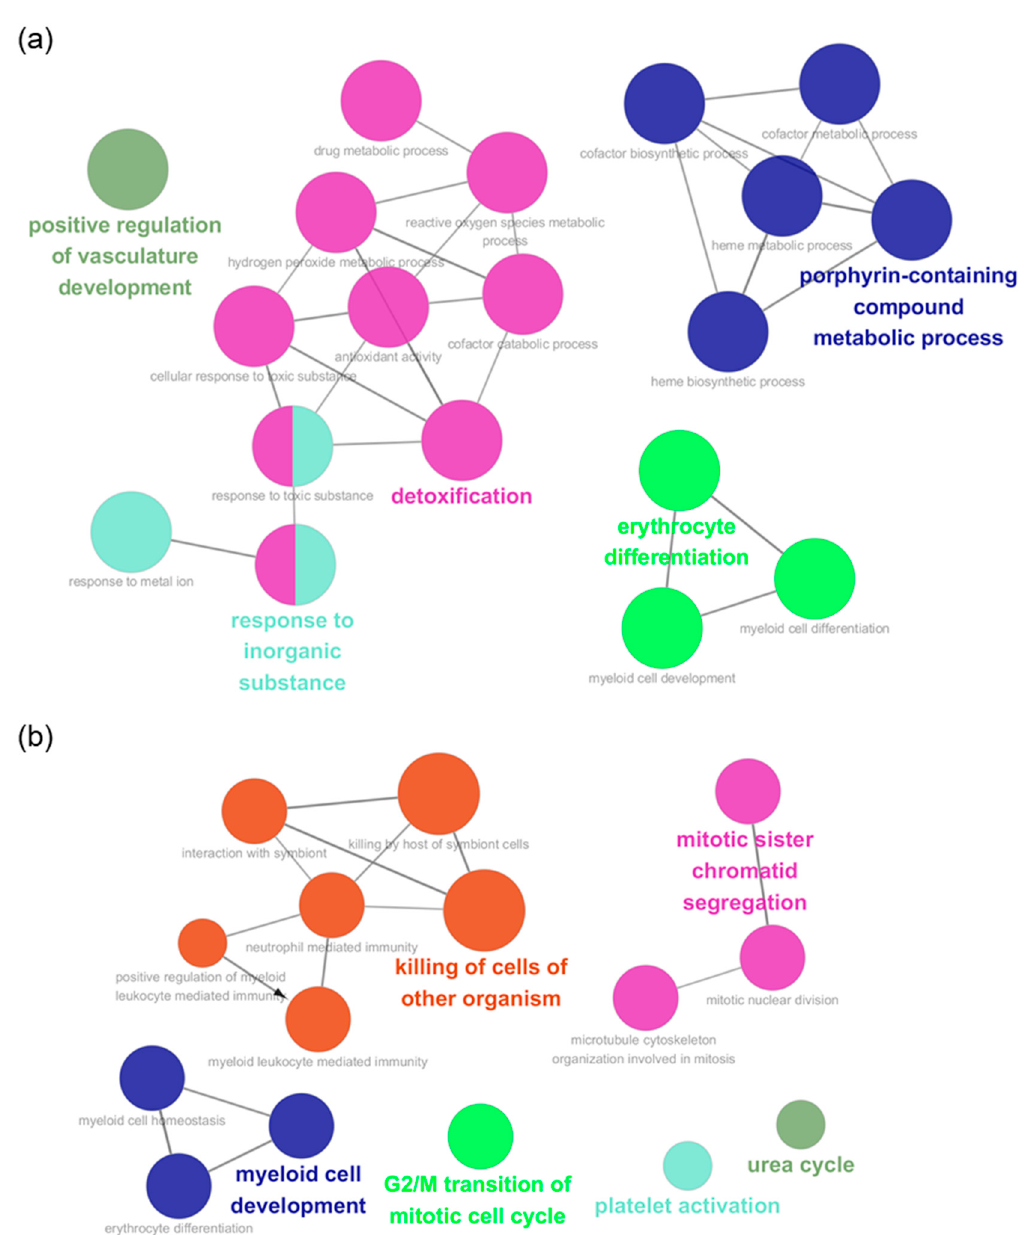
Figure 3. The IDO shRNA-mediated network of biological processes. The Scr IDO shRNA-treated splenocytes or neutrophils, and the identified genes, with differential expression in IDO shRNA-treated cells, were selected, and then the gene ontology analysis was performed via ClueGo and CluePedia. ( a ) The enriched biological processes in IDO shRNA-treated splenocytes ( p value <0.001). ( b ) The enriched biological processes in IDO shRNA-treated splenic neutrophils ( p value <0.01).